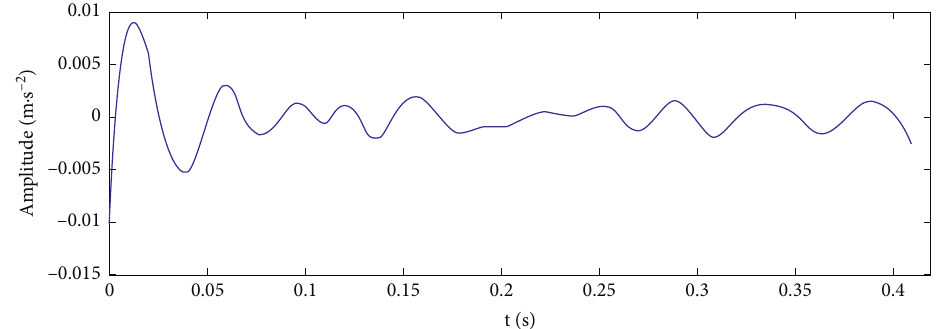
–0.015–0.01–0.00500.0050.01 Figure 16: Time-domain waveform of sensitive IMF component by EEMD